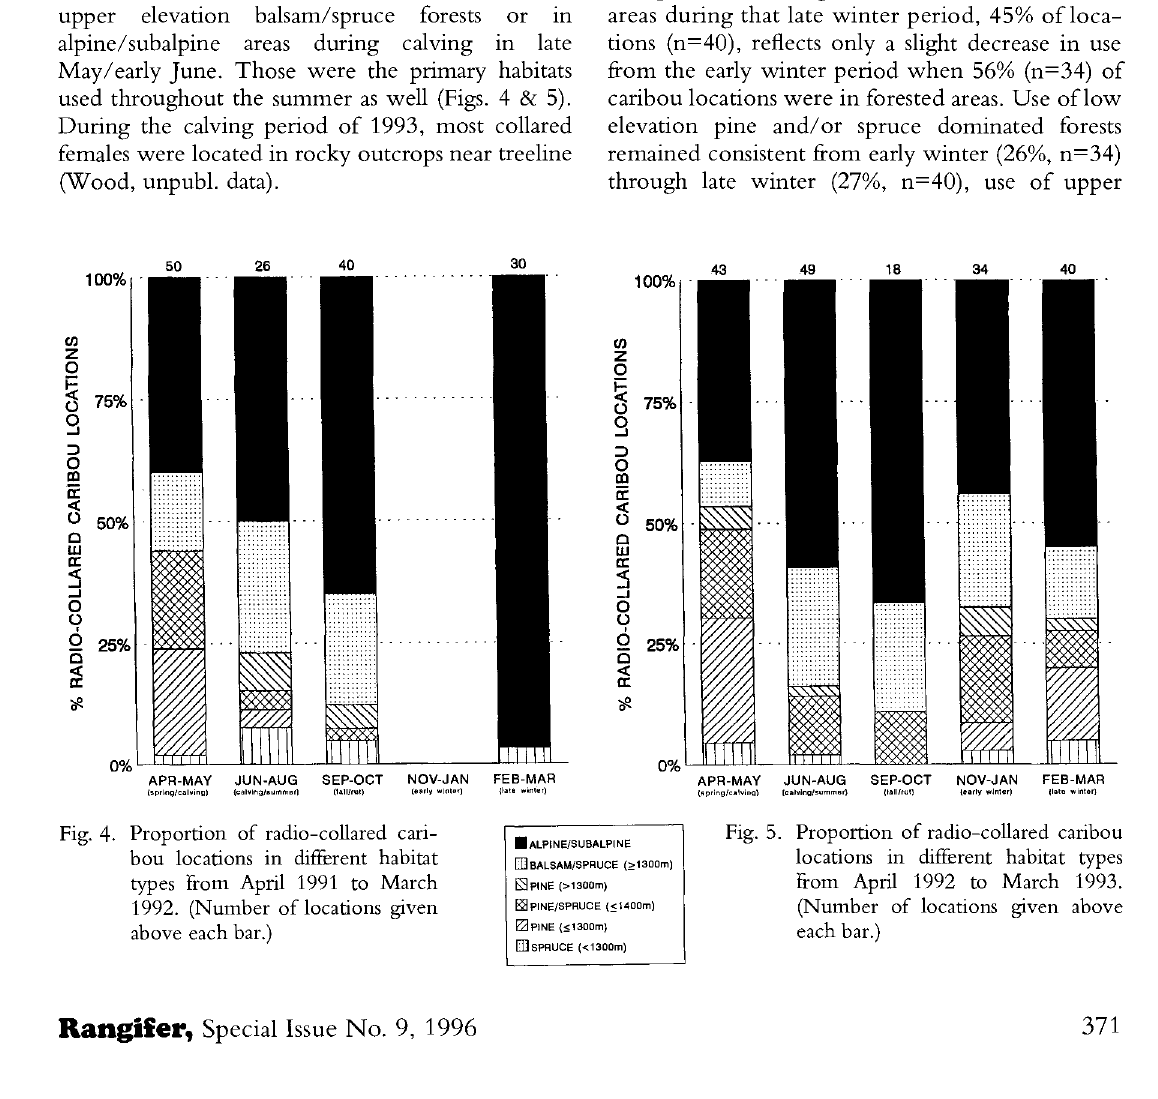
Fig. 4. Proportion of radio-collared cari bou locations in different habitat types from April 1991 to March 1992. (Number of locations given above each bar.)